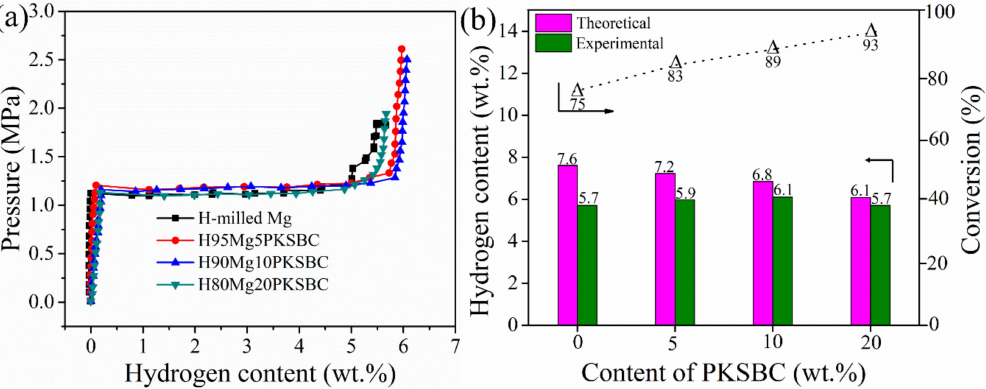
Figure 9. p-c- T curves of milled Mg and Mg-PKSBC composites ( a ) and bar chart comparison of theoretical, and experimental hydrogen capacity and conversion of Mg into MgH 2 against PKSBC content ( b ).